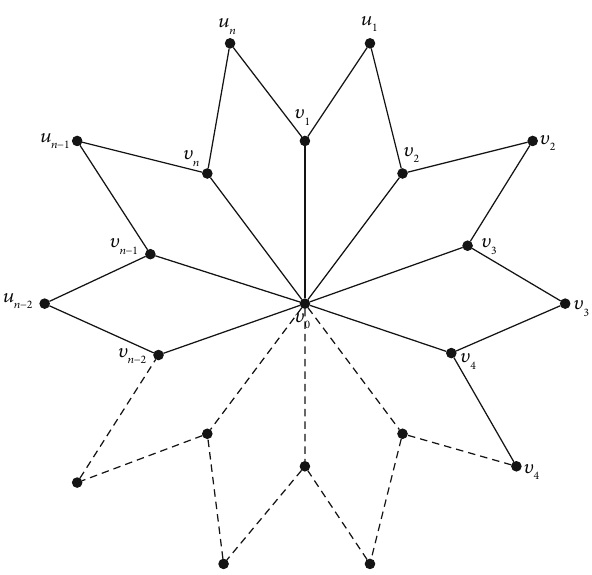
Figure 13: The gear graph G n with ordinary Illustration 6 . In Figure 12, we present P ð W 7 Þ with an edge 5 − graceful labeling and P ð W − graceful 9 Þ with an edge 2 labeling.